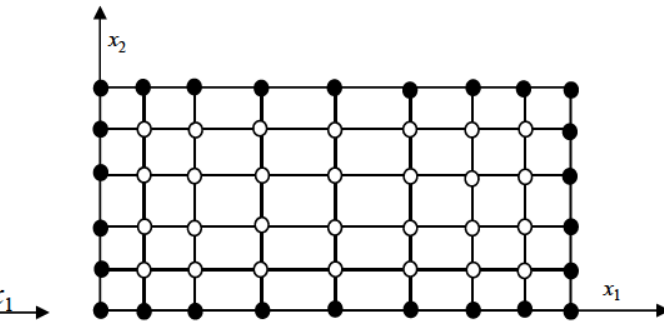
Figure 2: Discretization of the domain in strategy 2.